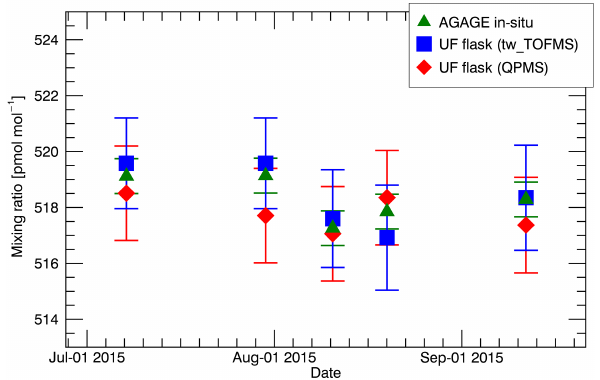
Figure 6. CFC-12 (CCl 2 F 2 ) mixing ratios at Mace Head Atmo- spheric Research Station, Ireland (53 ◦ 20 (cid:48)◦ N, 9 ◦ 54 (cid:48)◦ W, 30m above sea level) derived from 2L stainless steel flask samples measured with our GC-TOFMS (blue squares), our reference instrument (GC- QPMS, red diamonds) and values taken from the online measure- ment data of the in situ Medusa GC–MS (green triangles). Er- ror bars are 1-fold the measurement precision of each instrument (Medusa system: typical precision taken from Miller et al., 2008). Calibration scale of all instruments: